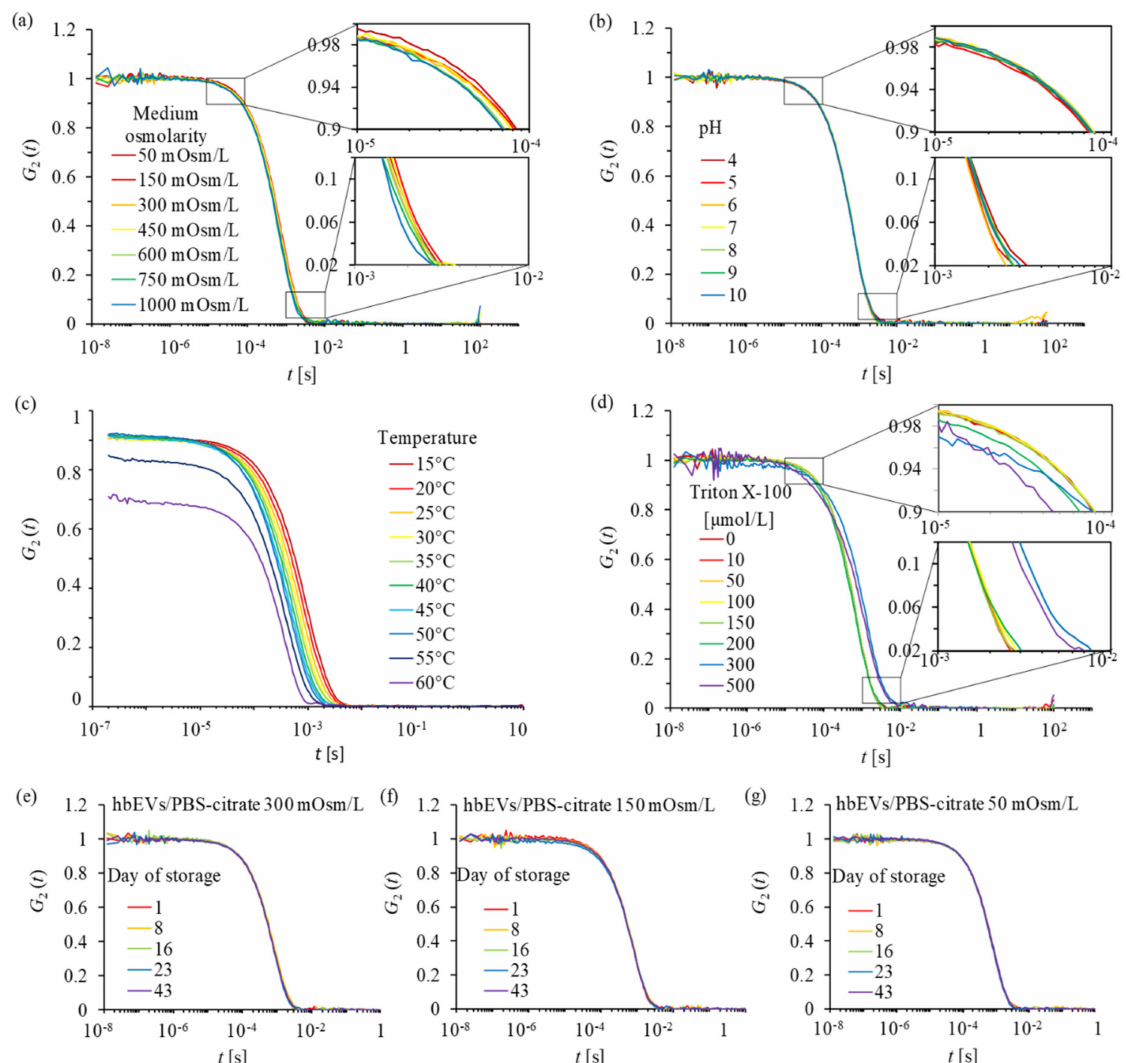
Figure A6. Normalized correlation functions G 2 ( t ) obtained in the analysis of hbEVs stability. Suspensions of hbEVs were analysed: ( a )—upon varying osmolarity of the medium, ( b )—varying pH values of the medium, ( c )—upon heating from 15–60 ◦ C, ( d )—in presence of increasing concentrations of the surfactant Triton X-100. hbEVs suspended in media with osmolarites 50, 150, and 300 mOsm/L were further assessed on days 1, 8, 16, 23, and 43 after the isolation from the erythrocyte suspension that had been aged in vitro. The results are presented in panels ( e )—50 mOsm/L, ( f )—150 mOsm/L, ( g )—300